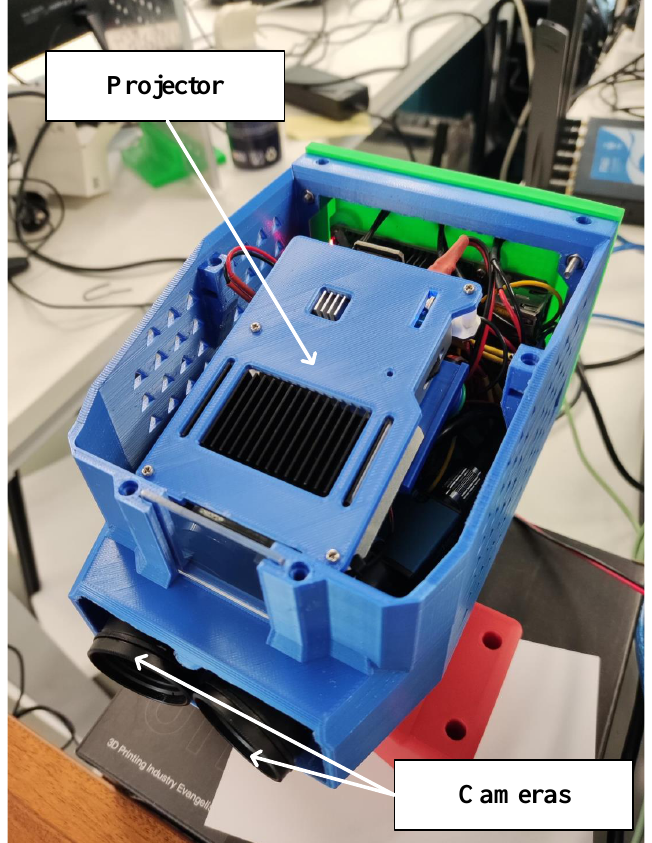
Figure 14. The structured light